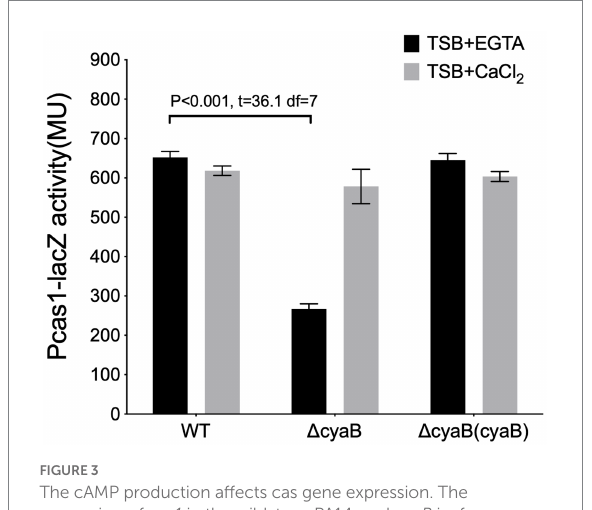
FIGURE 3 The cAMP production affects cas gene expression. The expression of cas1 in the wild-type PA14, and cyaB in-frame deletion mutants, Δ cyaB and the cyaB complement , Δ cyaB (cyaB) , grown in calcium depleted (TSB+ EGTA) and calcium-rich (TSB + CaCl 2 ) media. Data represents the Mean ± SD of six independent experiments. Statistical analysis was conducted by student’s t -test with a p value of < 0.05 is considered